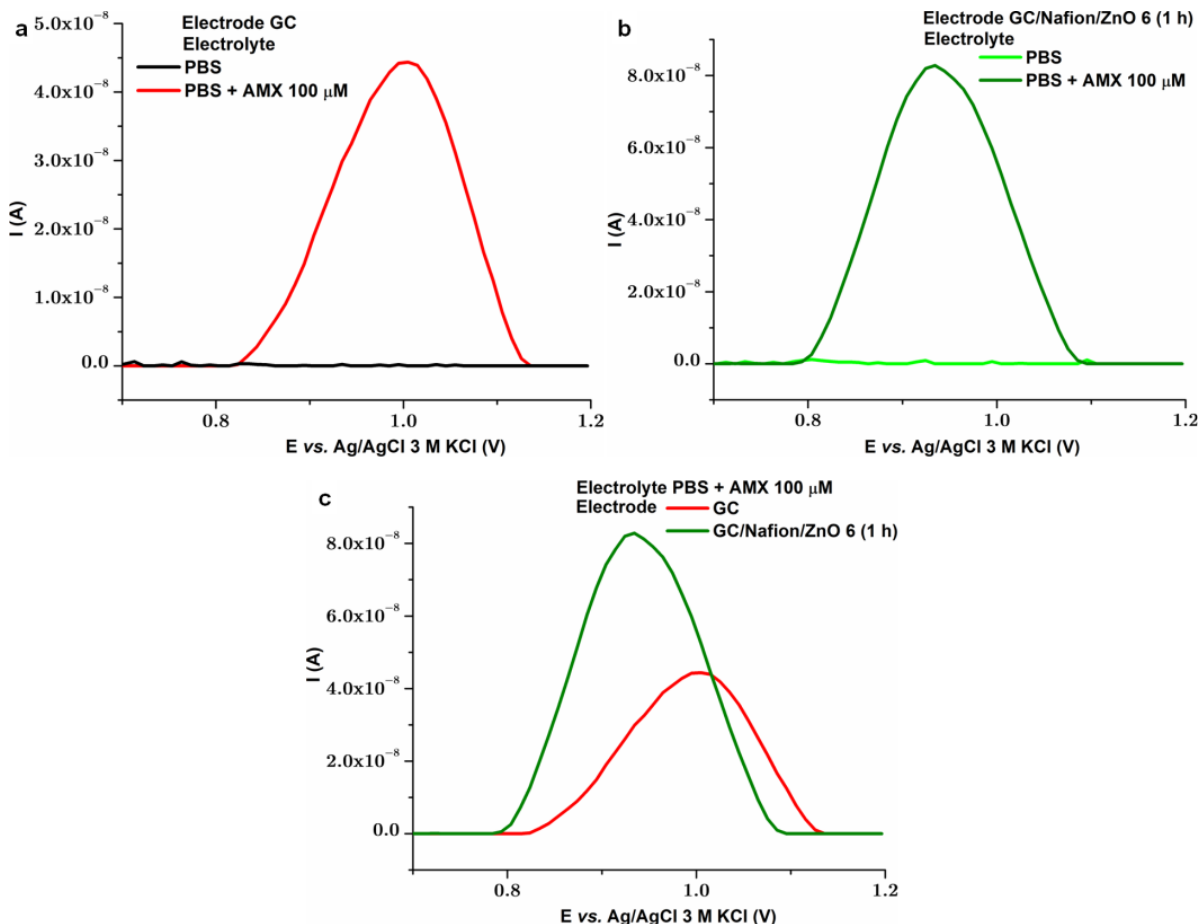
Figure 5. DPV curves corresponding to ( a ) GC in PBS and PBS with AMX 100 μM , ( b ) GC/Nafion/ZnO 6 (1 h) in PBS and PBS with AMX 100 μM and ( c ) comparation between GC and GC/Nafion/ZnO 6 (1 h) in PBS with AMX 100 μM .